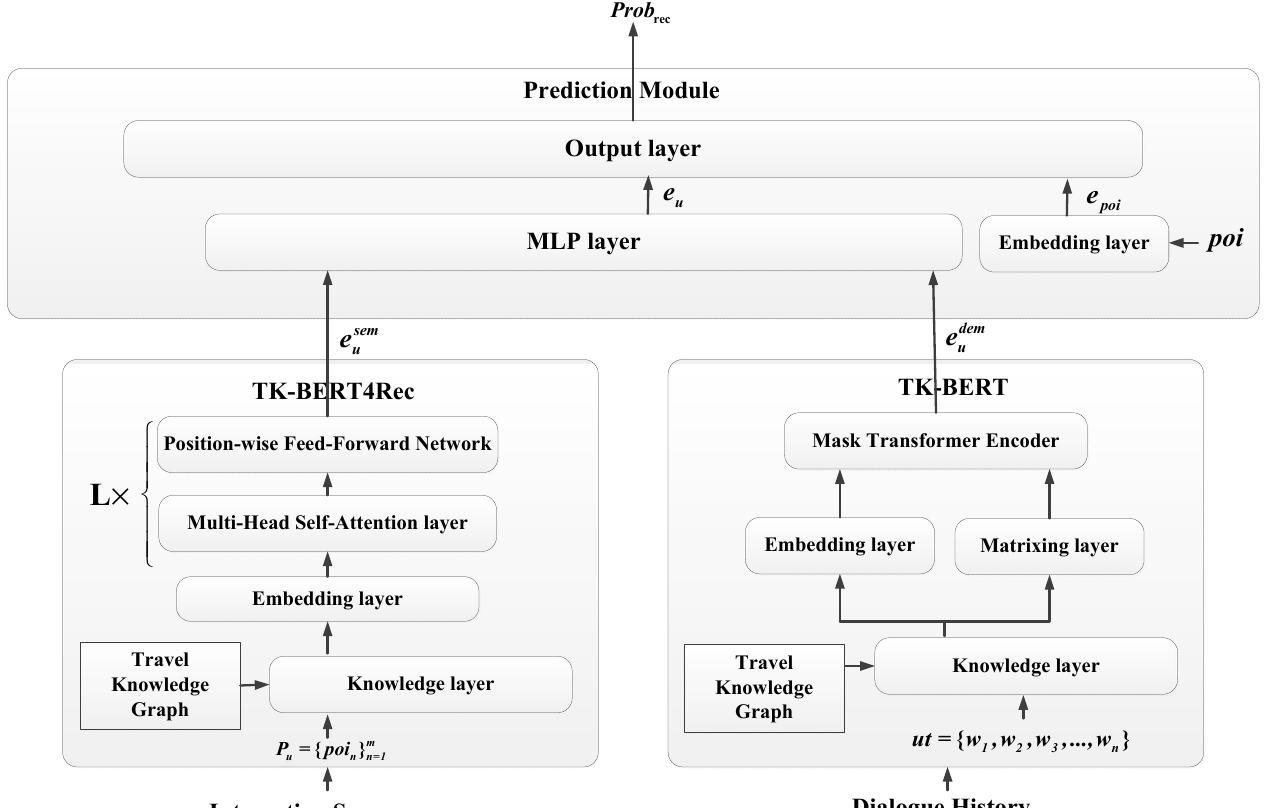
Figure 1. The architecture of the proposed DTCRSKG model. It contains two major parts, i.e., the TK-BERT4Rec part that learns user interaction representation and the TK-BERT part that learns di- alogue representation.